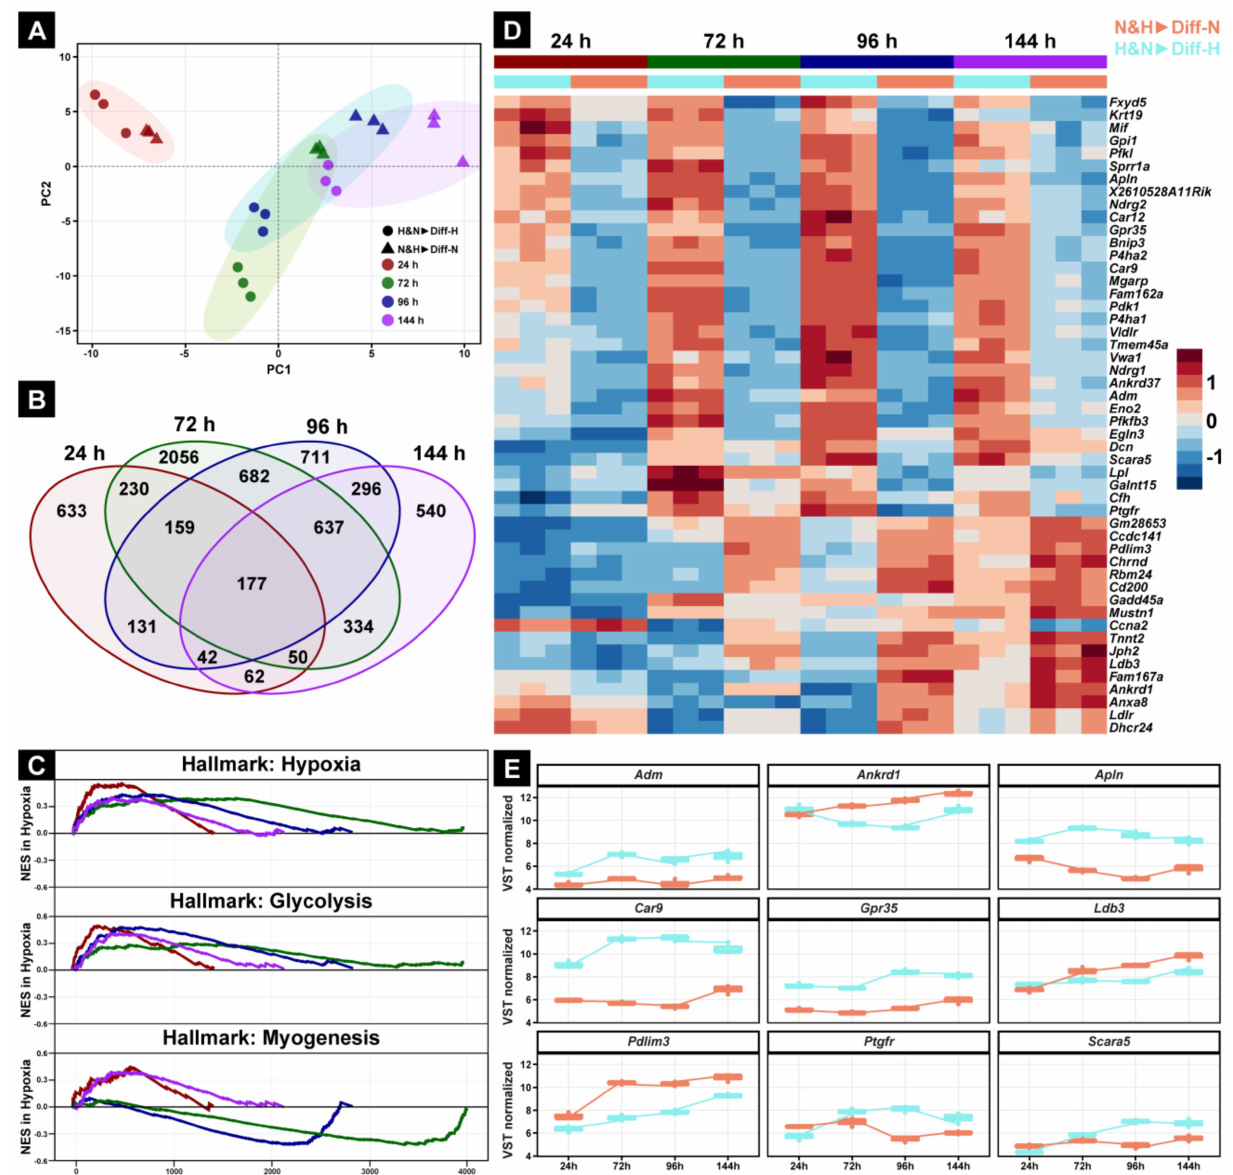
Figure 7. Comparison of gene expression between N&H (cid:183) Diff-N and H&N (cid:183) Diff-H. The first principal component (PC1) and second principal component (PC2) cluster analysis showed no initial difference between N&H (cid:183) Diff-N and H&N (cid:183) Diff-H 24 h after the onset of myogenic differentiation ( A ). The Venn diagram shows 177 genes present at all analyzed time points ( B ). Visualization of hypoxic-dependent hallmarks over 144 h shows the most positively (NES > 0) or negatively (NES < 0) regulated gene sets in the myoblast group H&N (cid:183) Diff-H compared with the normoxic group, N&H (cid:183) Diff-N ( C ). The heat map ( D ) includes the top 50 genes with the greatest variance within 144 h out of the 177 genes shown in ( B ). A positive value indicates higher expression; a negative value indicates lower expression. The nine most promising genes were extrapolated from the heat map and their activation under both oxygen conditions was assessed and directly compared over 144 h. ( E ) Genes are sorted